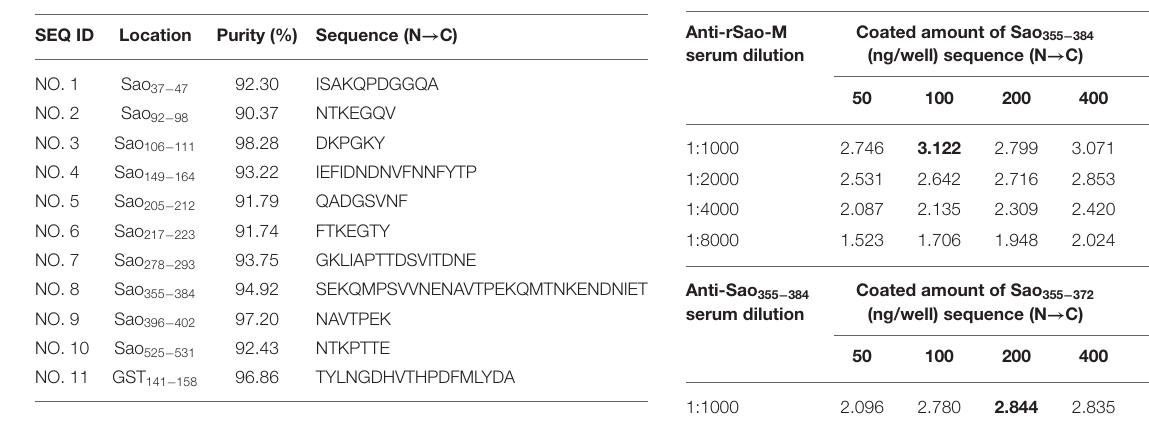
TABLE 2 | Determination of the coating amount of antigen and the working concentration of